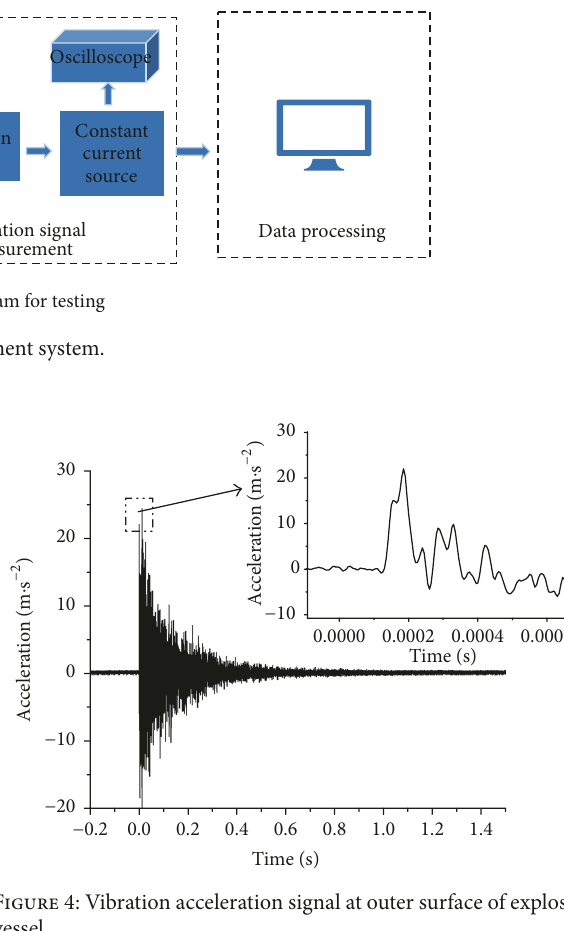
Figure 3: Vibration acceleration signal at inner surface of explosive vessel.